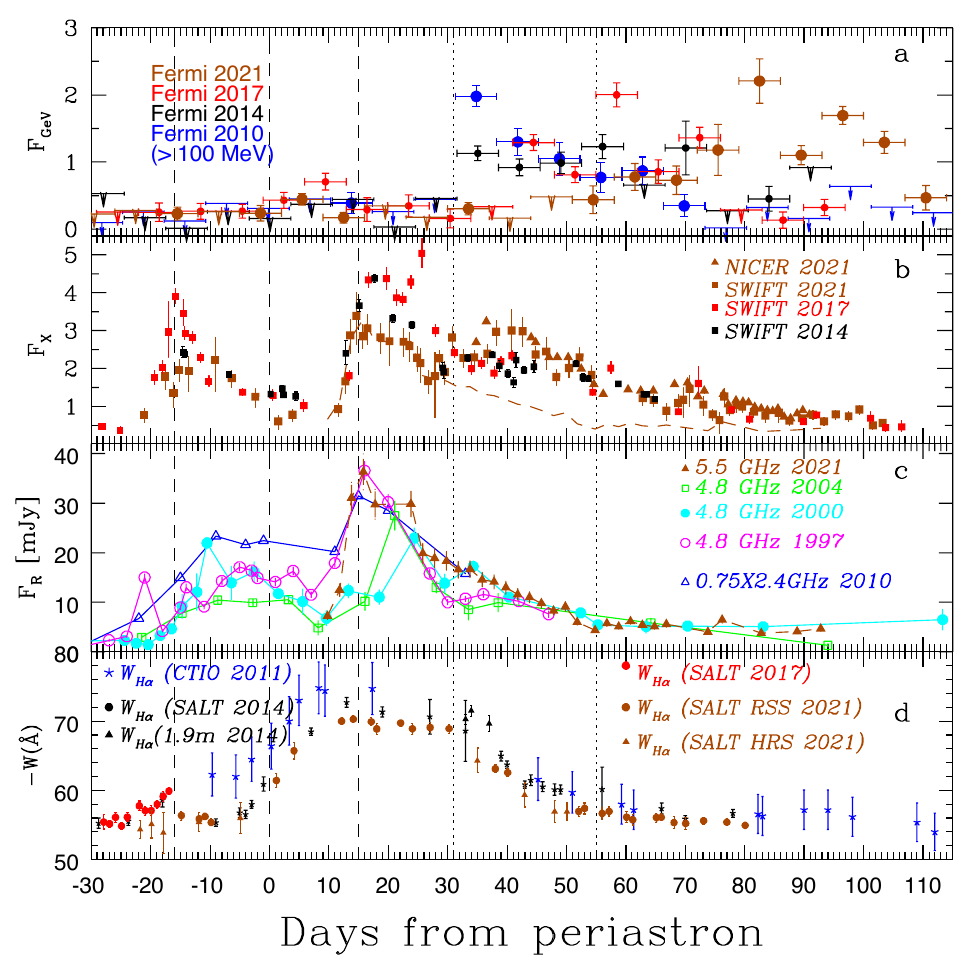
Figure 1. Evolution of PSR B1259-63 flux over the different periastron passages. Dashed lines corre- spond to the periastron and to the moments of disappearance (first non-detection) and reappearance (first detection) of the pulsed emission, as observed in 2010 [17]. Dotted lines correspond to the first appearance of the detection in GeV band at a day time scale in 2010 and 2021. ( a ) Fermi/LAT flux mea- surements in the E > 100 MeV energy range with a weekly bin size. Flux is given in 10 − 6 cm − 2 s − 1 . ( b ) absorbed 1–10 keV X-ray flux in units of 10 − 11 erg cm − 2 s − 1 . Scaled 5.5-GHz radio data from 2021 are also shown in this panel with a gold dashed line for comparison. ( c ) radio flux densities in mJy. Radio data for the years 1997, 2000 and 2004 are taken from [12]. Radio data from 2010 are taken from [17] and are normalized by a factor 0.75. Please note that data from different years are taken at different frequencies. ( d ) H α equivalent width. Data from 2011 are taken from [20], and 2014 and 2017 data are taken from